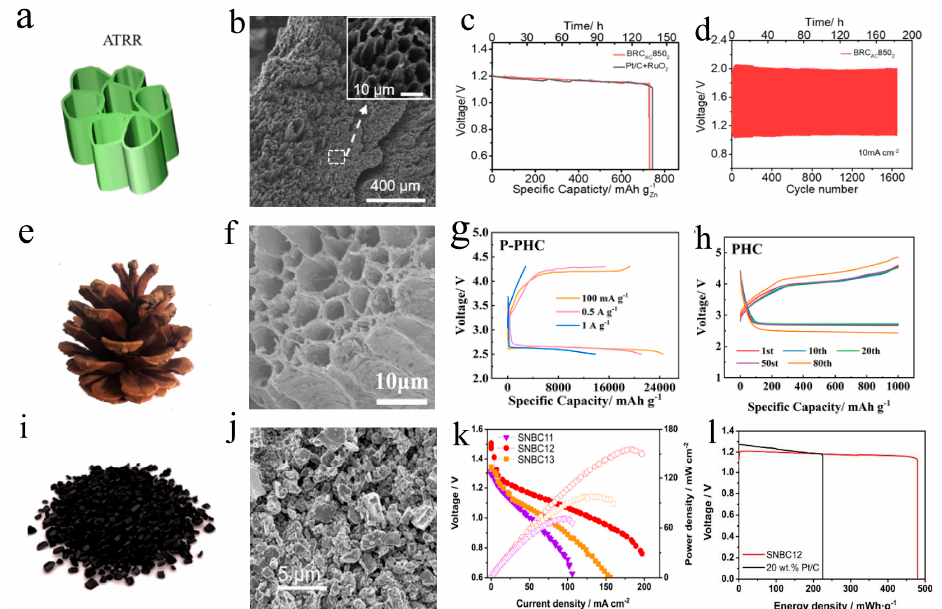
Figure 4. Biochar with heteroatoms, being cathode materials for metal–air batteries; biomass, SEM image of biochars, electrochemical performance curves. ( a – d ) Coptis chinensis. Adapted with